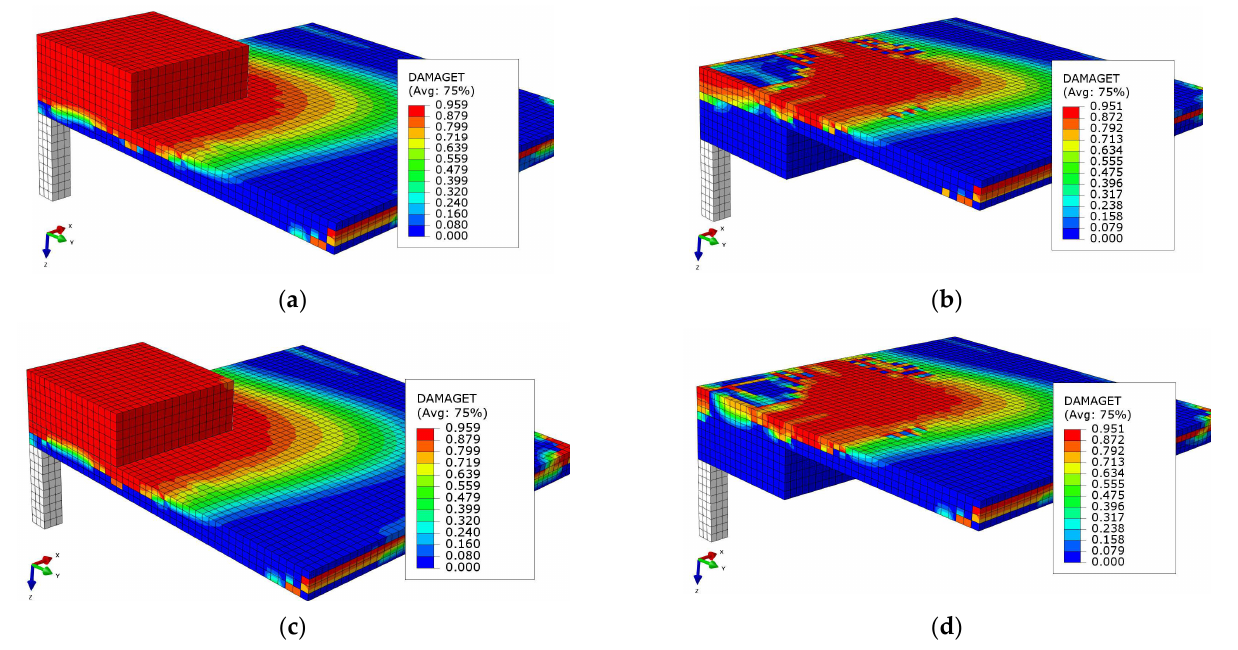
Figure 15. Tensile damage diagrams of tensile sides of specimens ZM01–ZM04 at ultimate load: ( a )